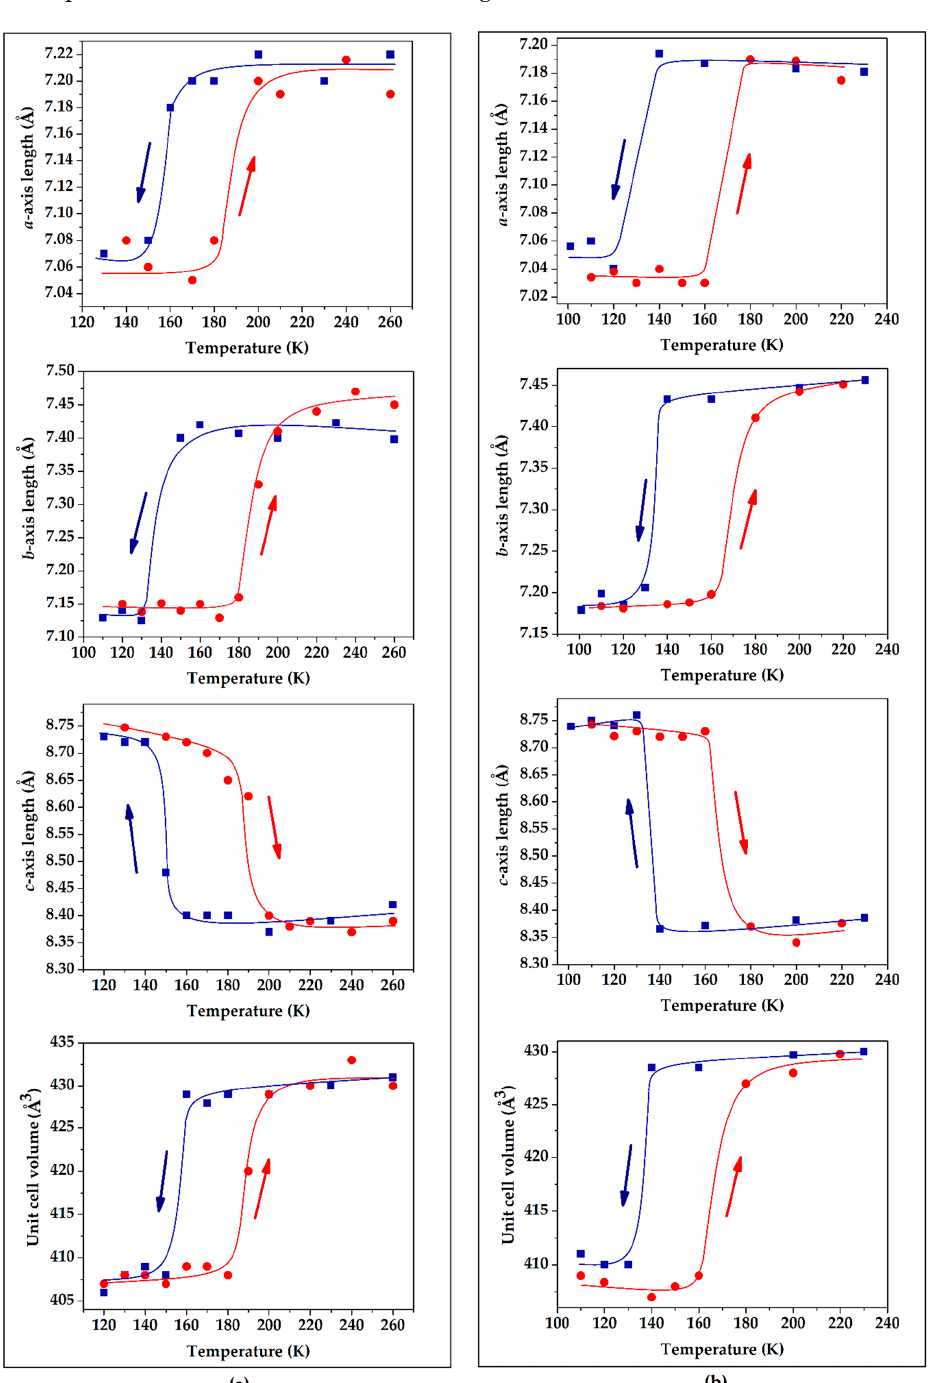
Figure 2. Temperature dependences of the crystal lattice parameters ( a axis, b axis, c axis, and unit cell volume) of 1 ( a ) and 2 ( b ) upon heating ( ● ) and cooling ( ■ ). As expected, the crystallographic parameters change from LS to HS. There is a positive thermal expansion along a and b axes, while a negative thermal expansion takes place along c axis. From 120 to 200 K, the a and b parameters expand by ∼ 2% and ∼ 4%, respectively, while the c axis shrinks by ∼ 4% for both complexes. This indicates the strong